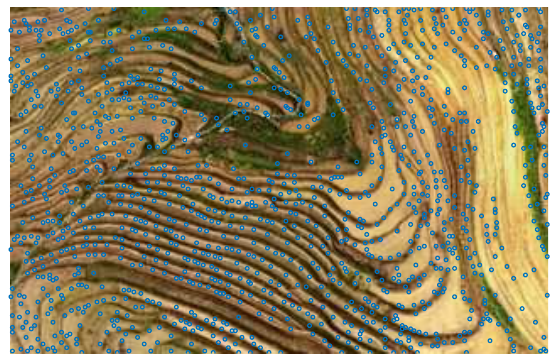
Figure 2. An example of feature points extraction. There are 1270 feature points extracted and denoted by blue